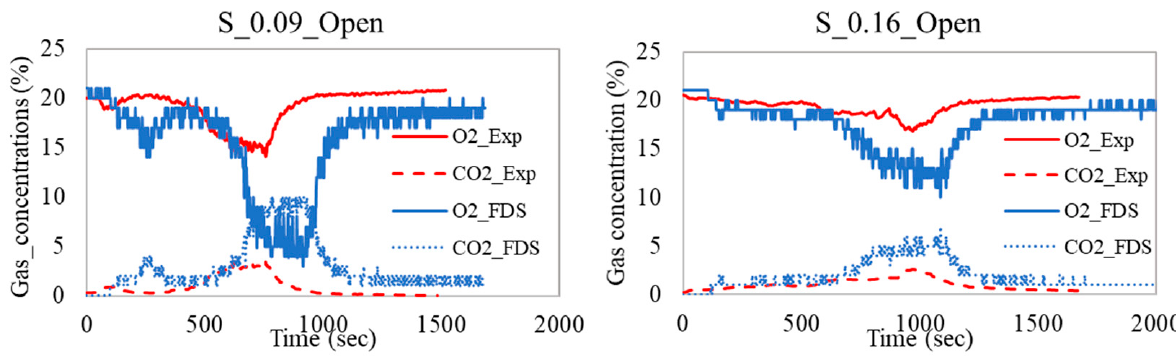
Figure 17. Gas concentration at the back of the compartment for the S_0.09 and S_0.16 cases.